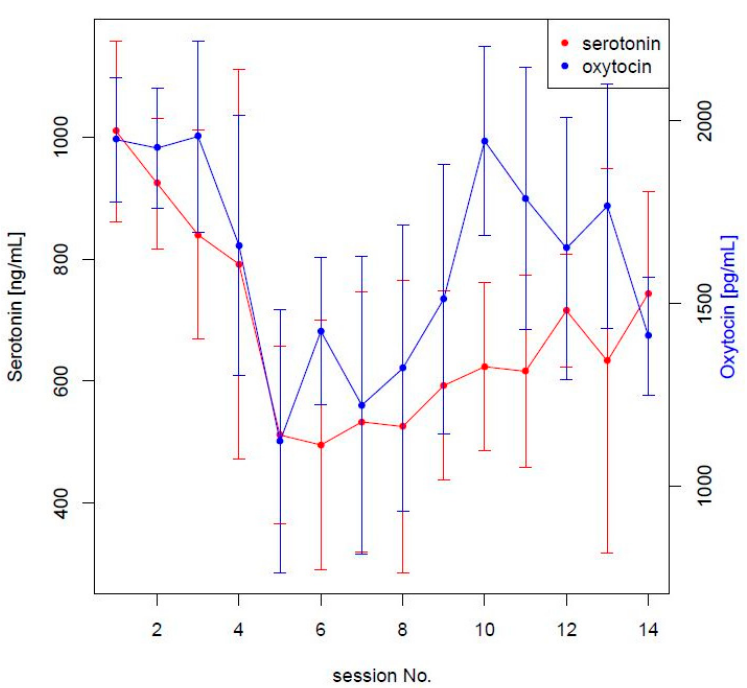
Figure 3. Standard deviations at each session were reported as vertical lines. Only serotonin and oxytocin were reported on different scales in order to appreciate a common biphasic pattern.